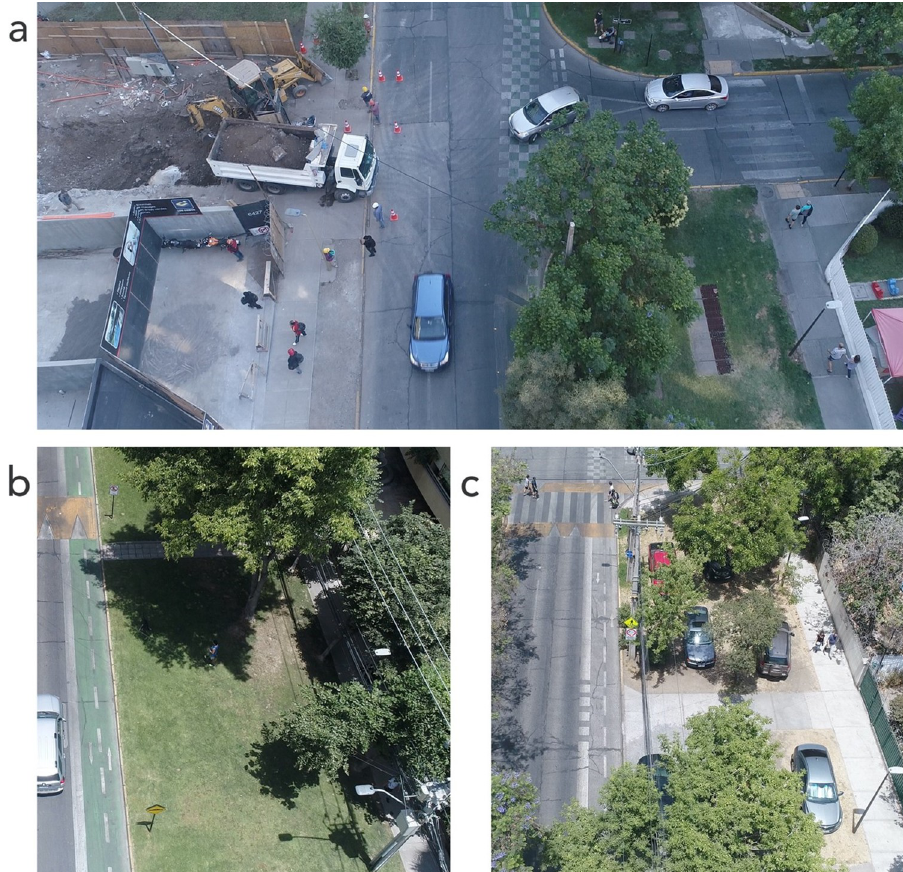
Fig 6. Intersection between Noruega and Carlos XII street (a). Grass and vegetation areas as improvised space for dogs (b). Grassy areas deteriorated by car parking (c). Source: original UAV imagery.